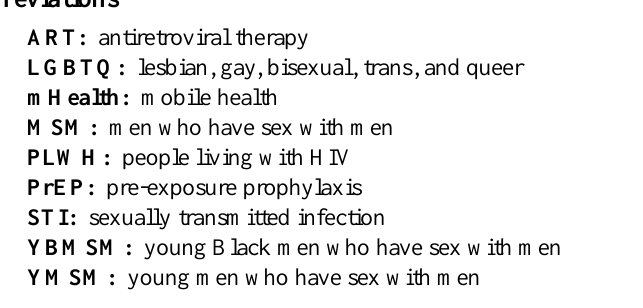
Abbreviations ART: antiretroviral